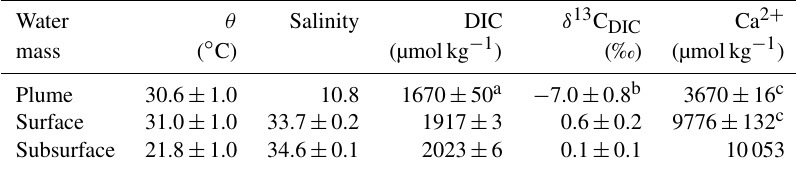
Table 1. Summary of endmember values and their uncertainties adopted in the three endmember mixing model.